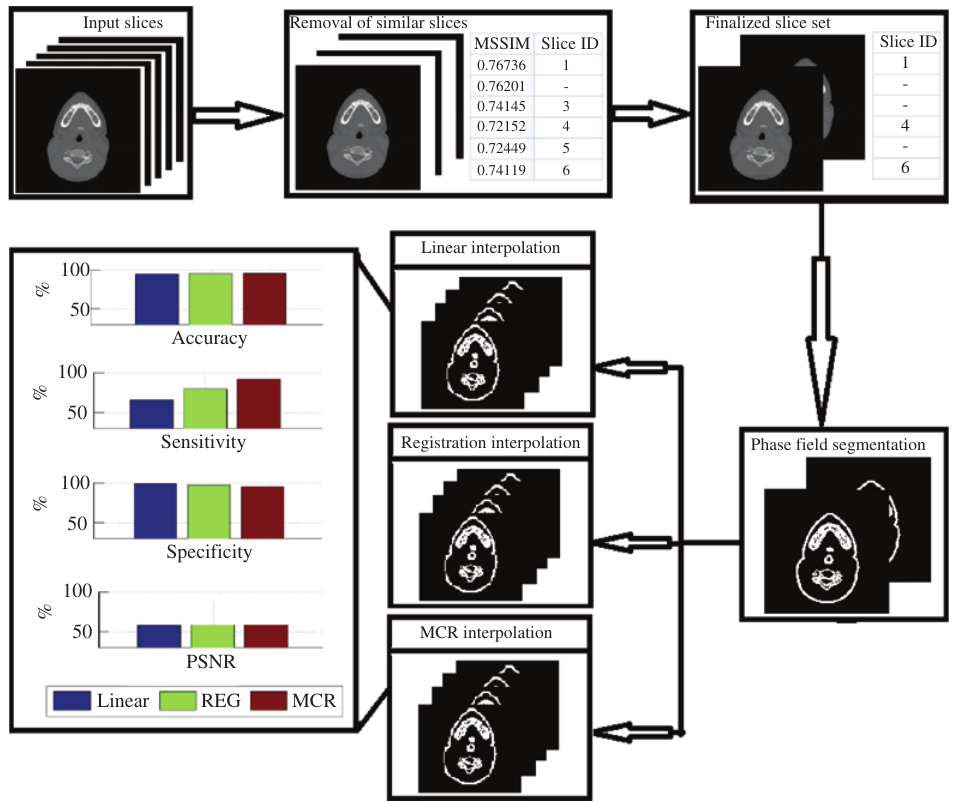
Figure 1: Graphical Abstract of the Proposed